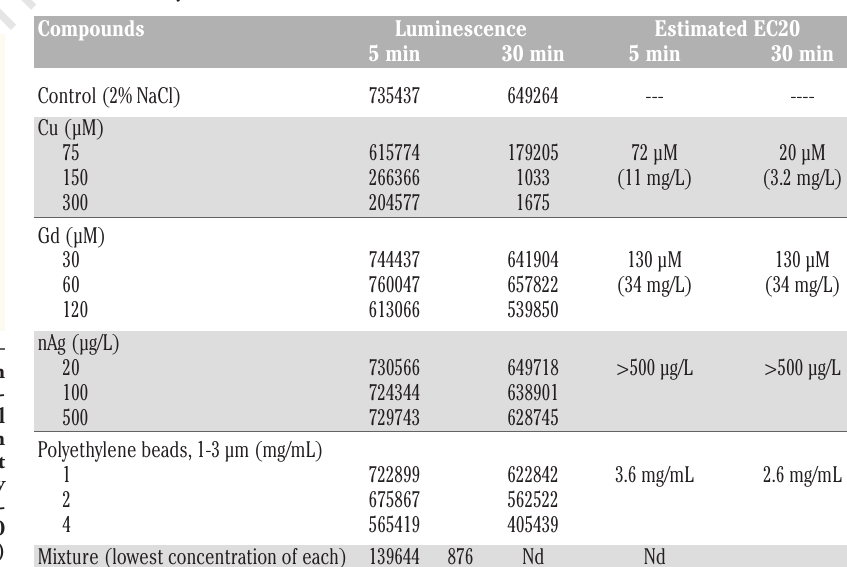
Table 1. Toxicity values of the selected contaminants.